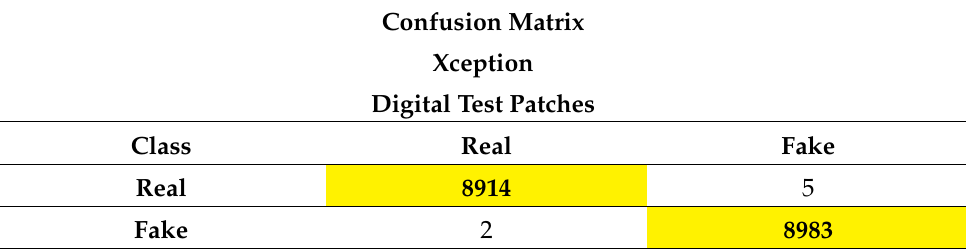
Table 7. Confusion matrix of XCEPTION 299 × 299 × 3 patches classified for digital GAN-image detec- tion.